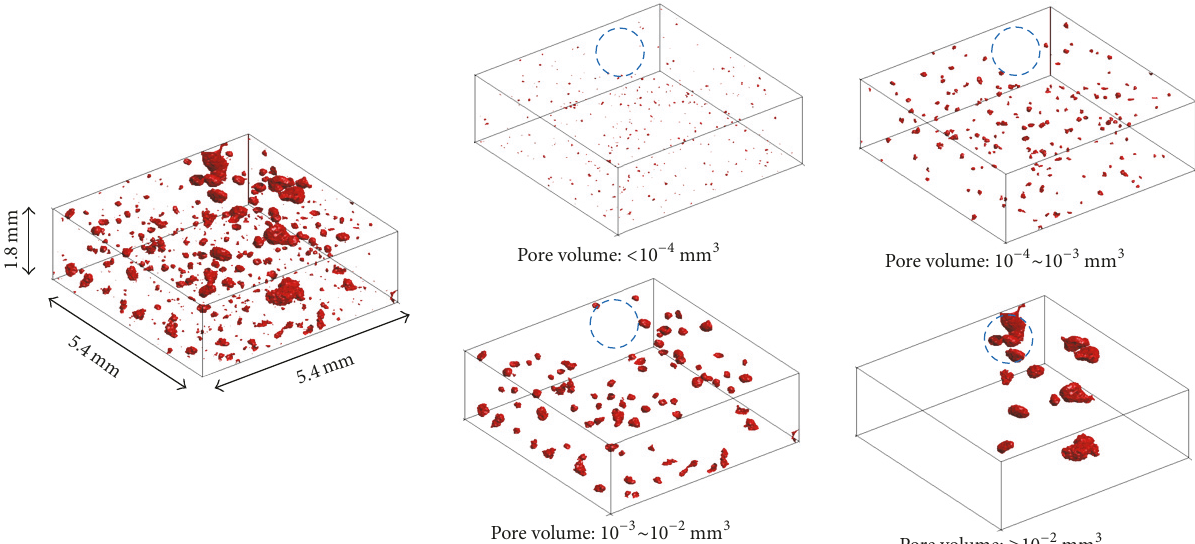
Figure 3: Reconstructed 3D micropore structures of the FASF sample (separated micropores based on pore-volume ranges).